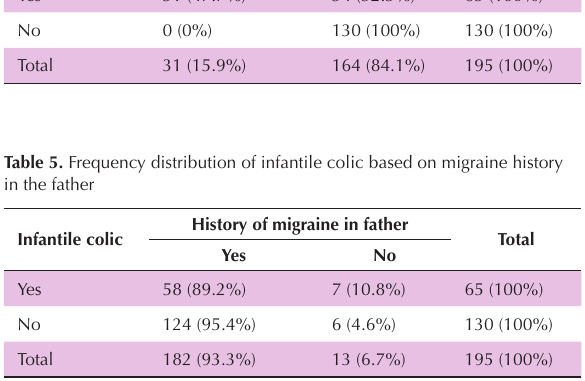
Table 2. Determining the relationship between infantile colic and migraine in parents History of migraine in Infantile colic